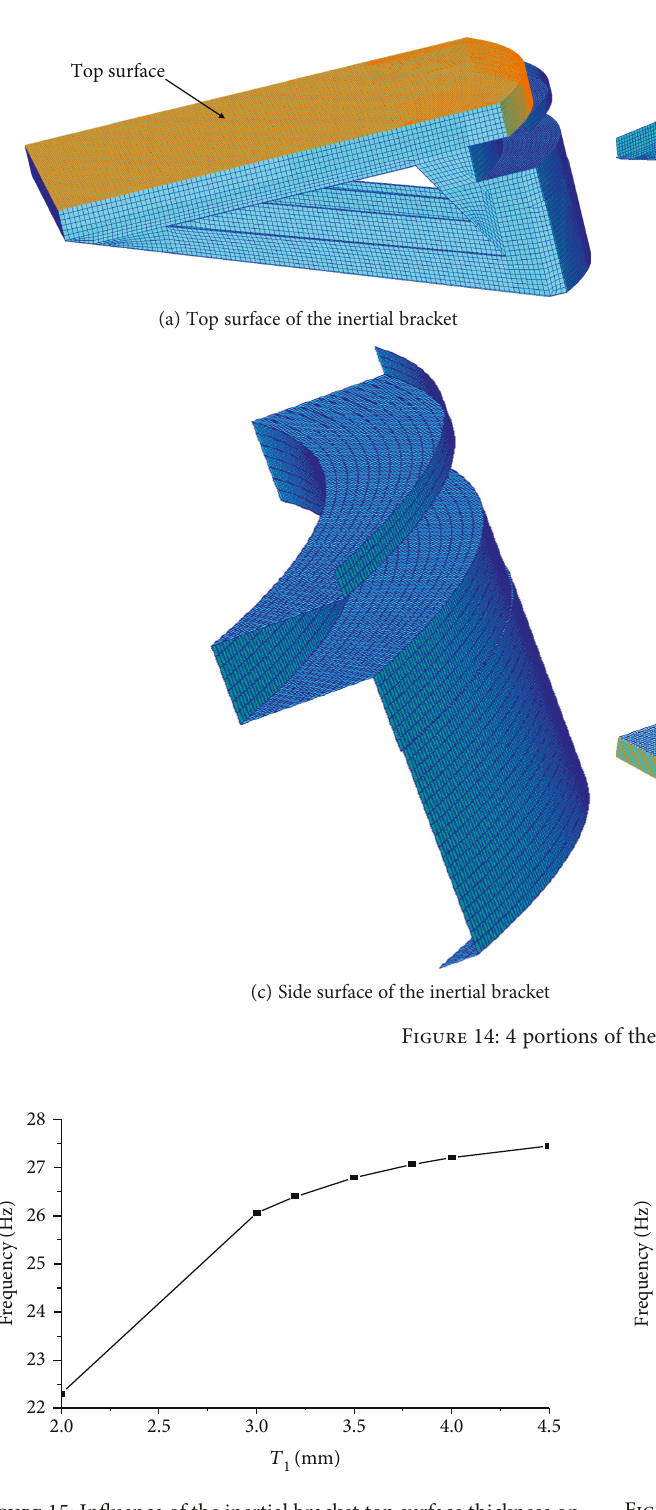
Figure 15: In fl uence of the inertial bracket top surface thickness on the fi rst modal frequency of the equipment bay.